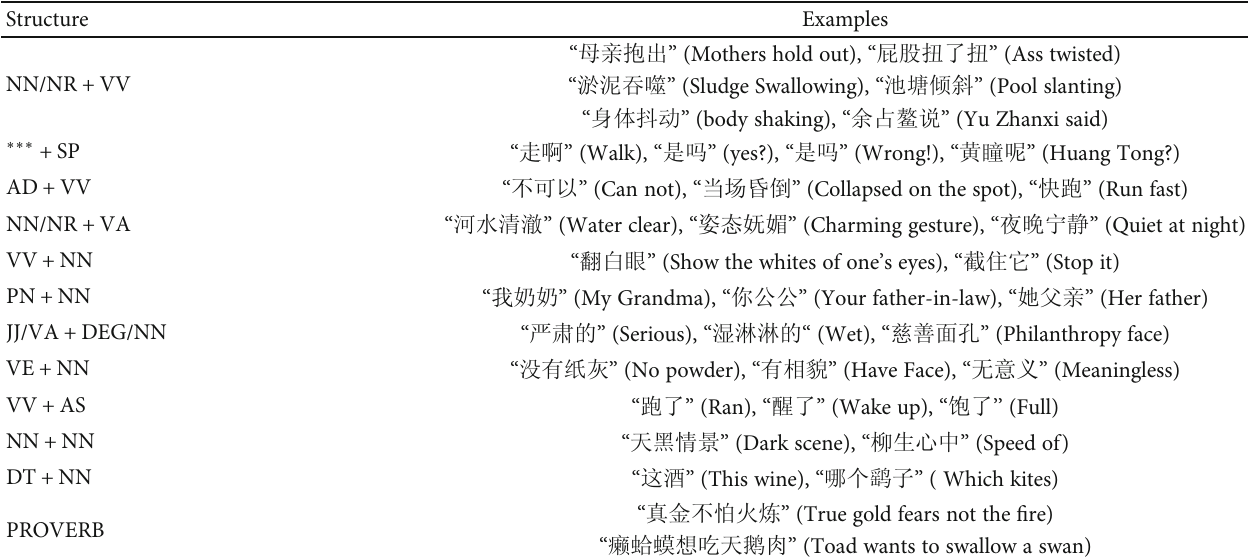
Figure 6: 2-gram structure proportion distribution. Table 9: Novel 2-gram list